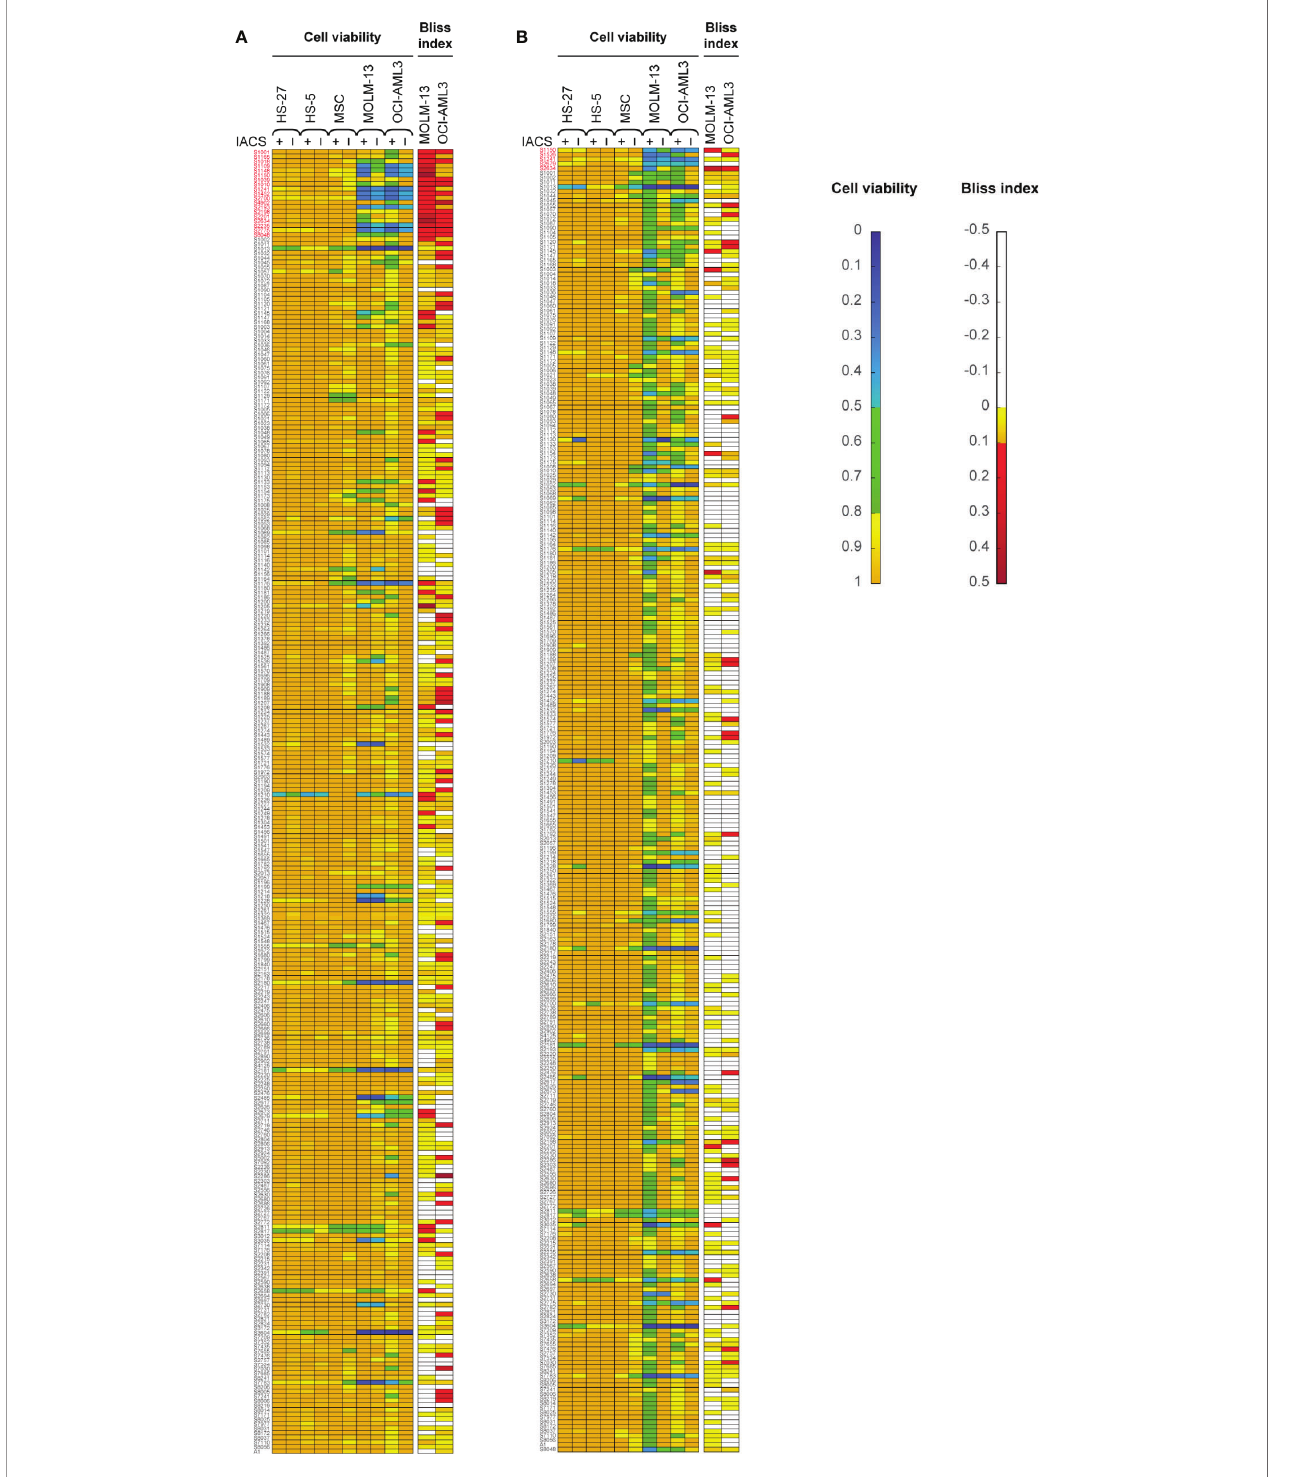
FIGURE 1 | The primary drug library screening identi fi es 21 top-hit drug synergy candidates in leukemia and bone marrow stromal cells treated under hypoxia (A) or normoxia (B) . Bliss index [for AML cell lines; top in both (A, B) ] and relative cell viability [for AML and bone marrow stromal cell lines; bottom in both (A, B) ] in cells treated with 30 nM IACS-010759 and/or 100 nM drug library compounds for 24 h and in 4 replicates. Top-hit drug candidates, satisfying the primary screening criteria (relative cell viability <0.8 or Bliss Index >0.1 for the leukemia cell lines, and limited effects on the bone marrow stromal cells), are marked in